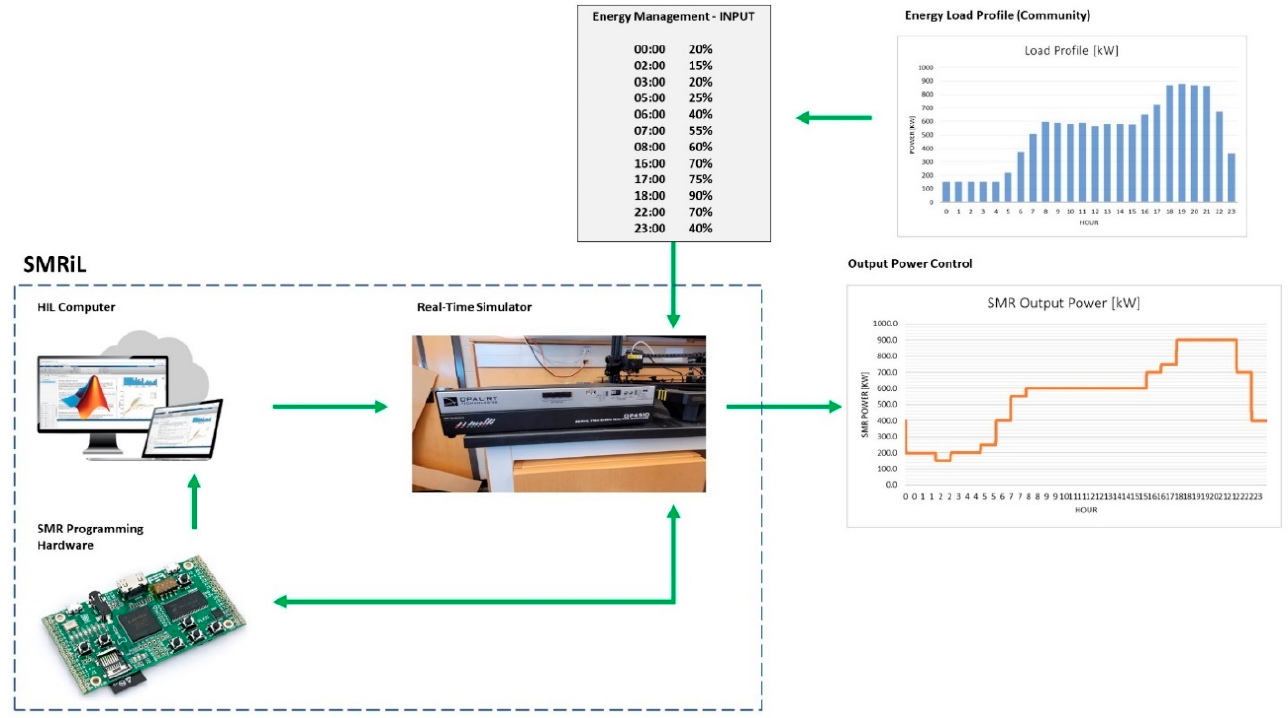
Figure 21. SMRiL demonstration.